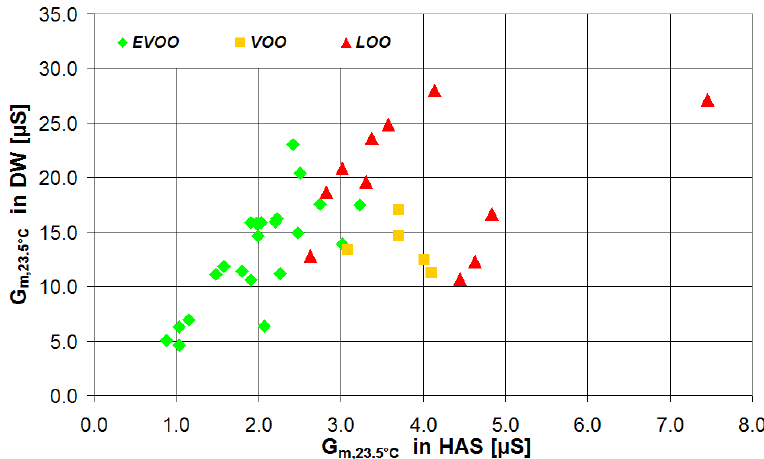
Figure 16. Scatter plot of the emulsion electrical conductance at 23.5 ◦ C using the DW reagent ( y -axis) vs. the emulsion electrical conductance at 23.5 ◦ C using the HAS reagent ( x -axis) for three different quality grades (EVOO, VOO, LOO).